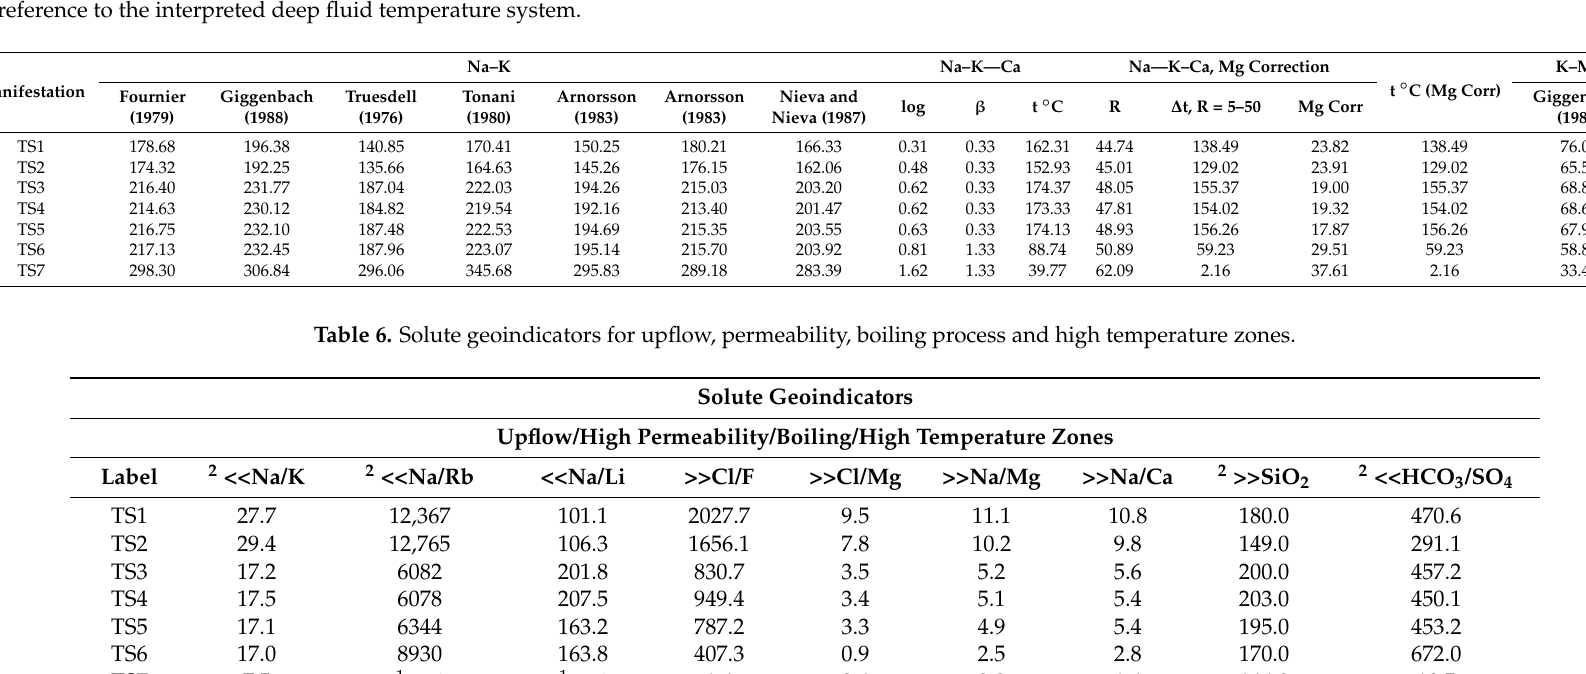
Table 5. The results of geothermometer calculations based on several pieces of literature on the reactive cation elements of thermal manifestations. The red box is a reference to the interpreted deep fluid temperature system.